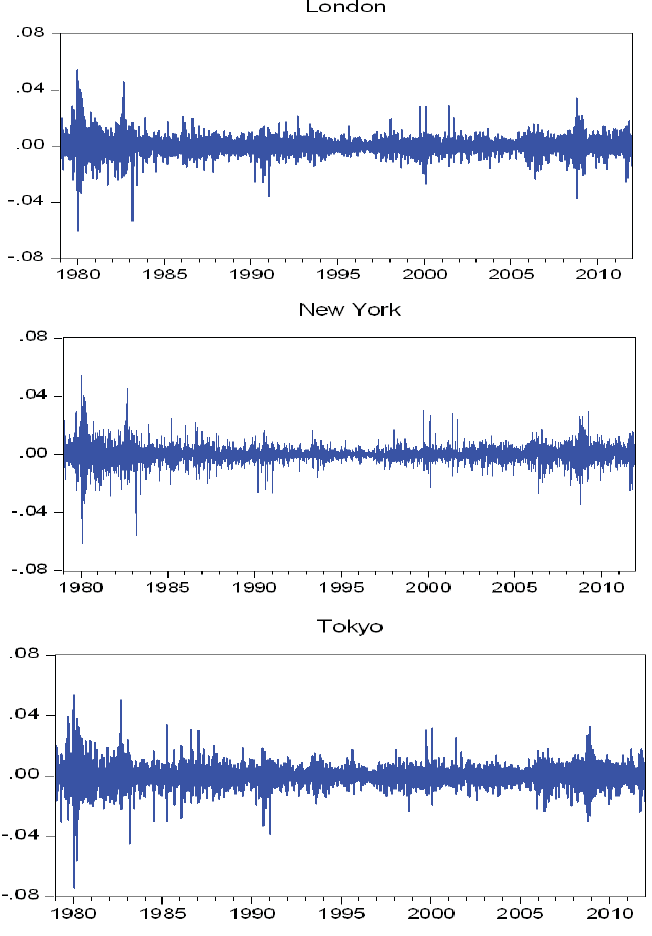
Fig. 1. Time series of daily returns for gold in London, Tokyo and New